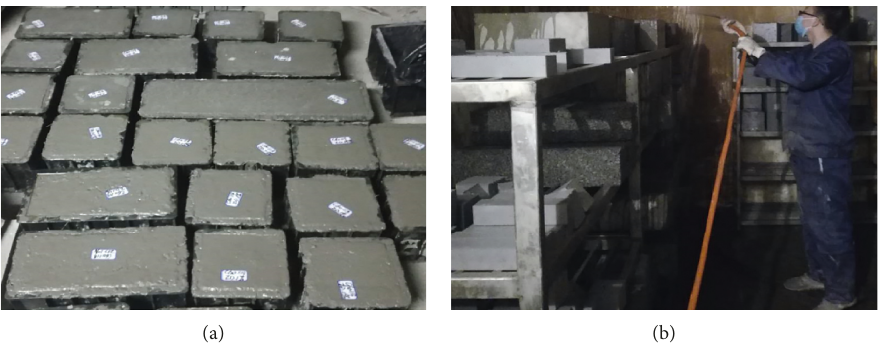
Figure 2: The manufacturing and curing operation of specimens.